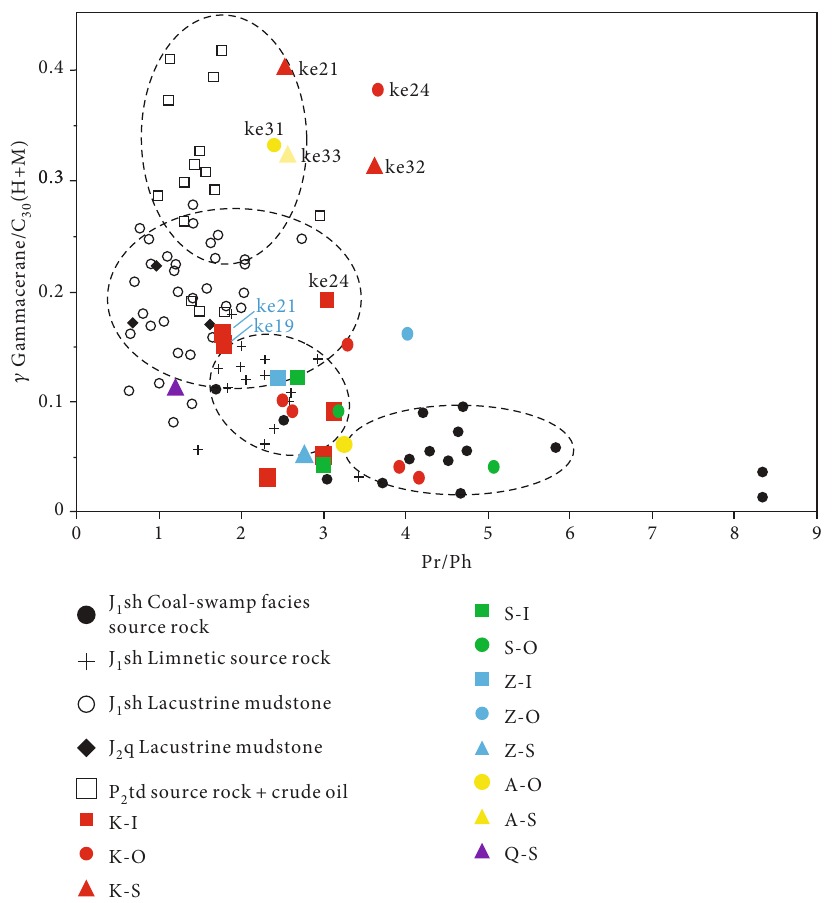
Figure 7: Cross-plot of Pr/Ph and γ -gammacerane/C (H+M) in the inclusions, oil, sandstones, and the typical source rocks of Turpan- 30 Hami Basin (modi fi ed according to literature [27]) Note: K-I: Kekeya-inclusion; K-S: Kekeya-sandstone; K-O: Kekeya-crude oil; S-I: Shanle-inclusions; S-O: Shanle-crude oil; Z-I: Zhaobishan-inclusions; Z-O: Zhaobishan-crude oil; Z-S: Zhaobishan-sandstone; A-O: Aketashi-crude oil; A-S: Aketashi-sandstone; Q-S: